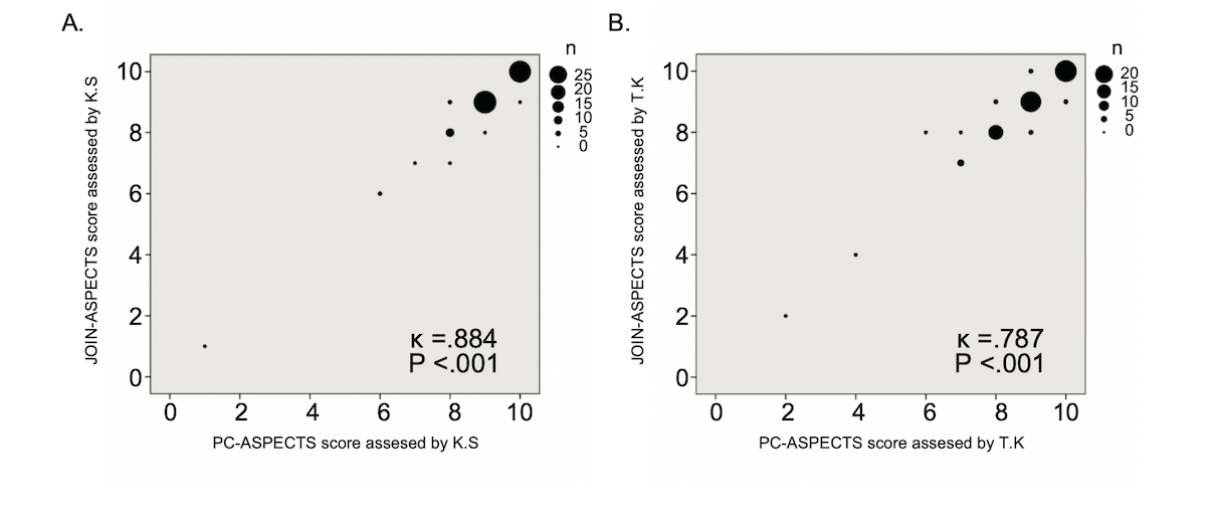
Figure 4. Scatter diagram of DWI-ASPECTS results of vascular neurologists KS (A) and TK (B) between JOIN-ASPECTS and PC-ASPECTS for